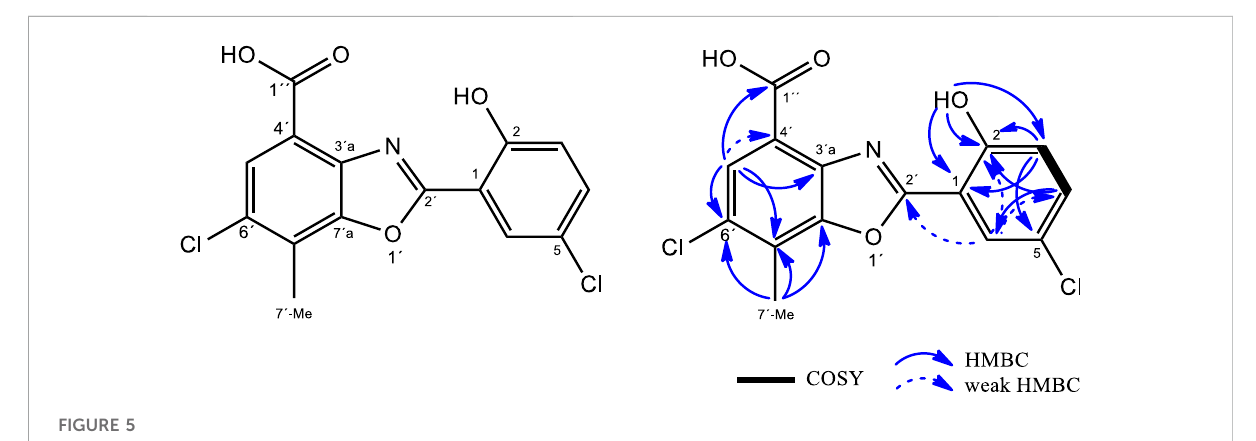
FIGURE 5 Structure of caboxamycin B (1) and key COSY/HMBC